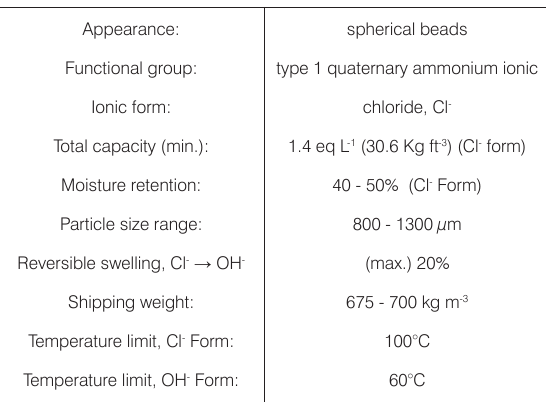
Table 1. Properties of the Purolite SGA- 600U/3472 ion exchange